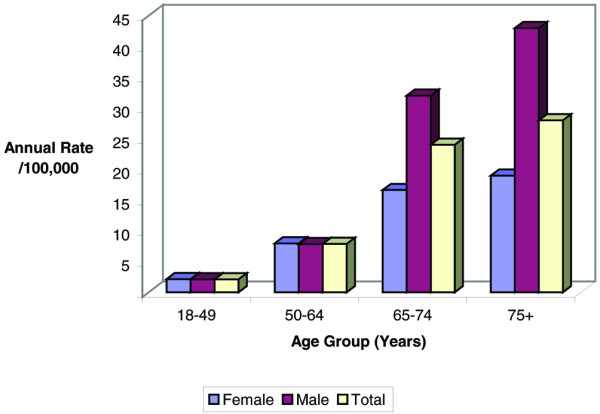
Age and sex-specific incidence rates of severe acute renal failure among adult residents admitted to a Calgary Health Region intensive care unit.